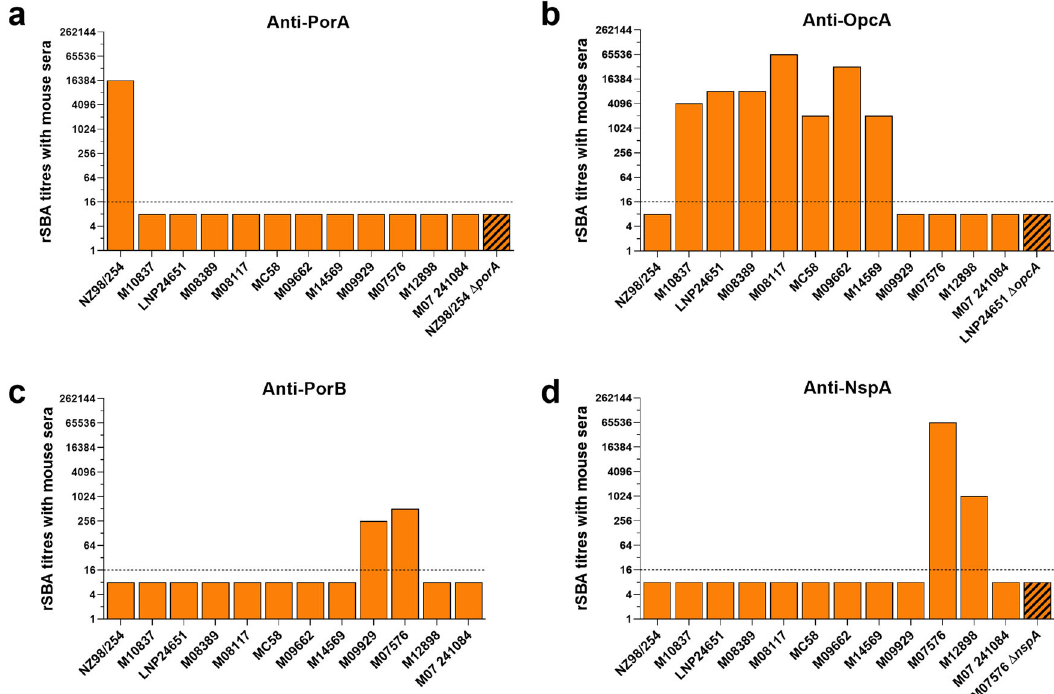
Fig. 3 PorA, OpcA, PorB, and NspA antibodies showed strain-speci fi c bactericidal killing. rSBA titers obtained using GMMA-PorA ( a ), GMMA-OpcA ( b ), rPorB ( c ), and GMMA-NspA ( d ) antisera are represented by histograms. Filled bars represent natural strains, while stripped bars indicate knockout mutants used as negative controls. rSBA titers ≥ 16 are considered positive (dashed lines). Sera used in all the analyses are pool of eight